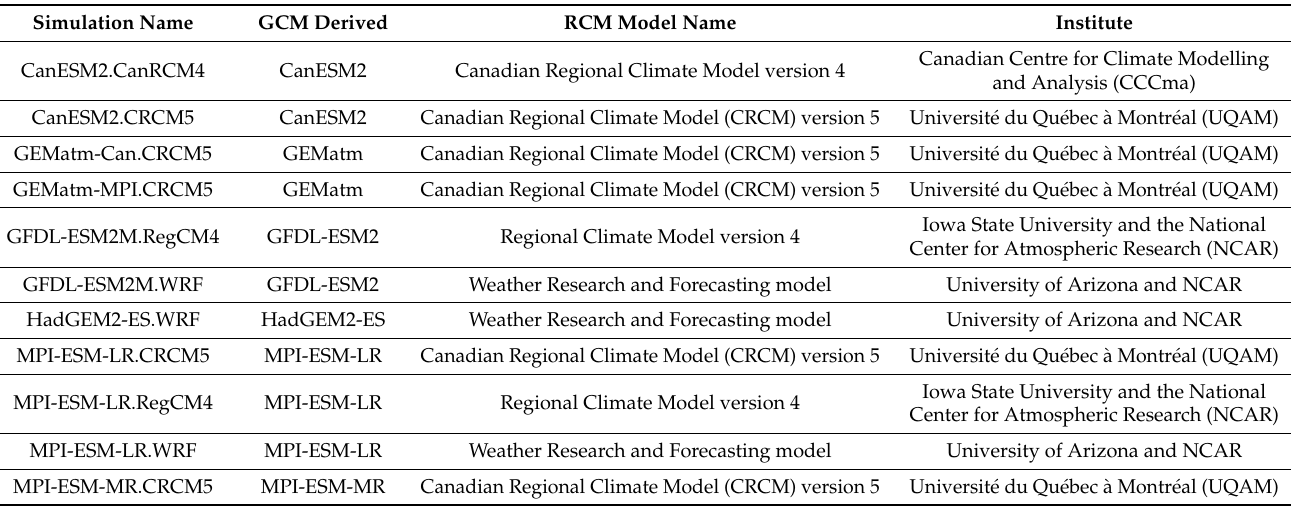
Table 2. Summary of NA-CORDEX